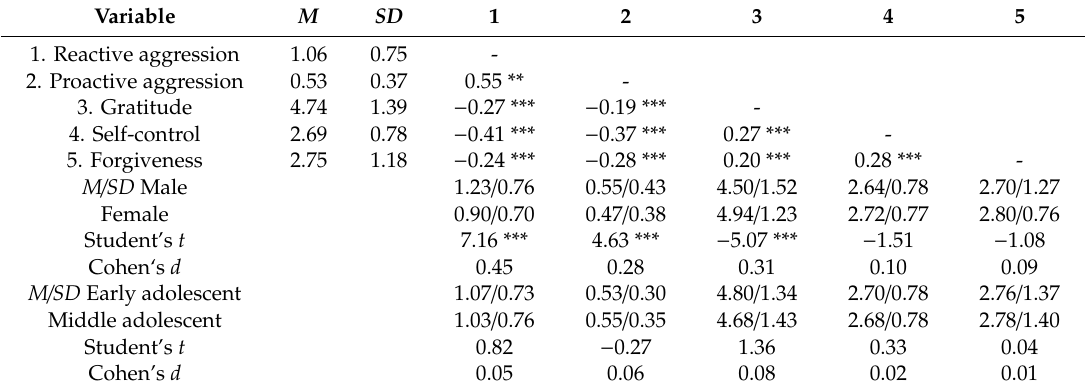
Table 1. Means, standard deviations, correlations, and mean comparisons by gender and stage of adolescence.